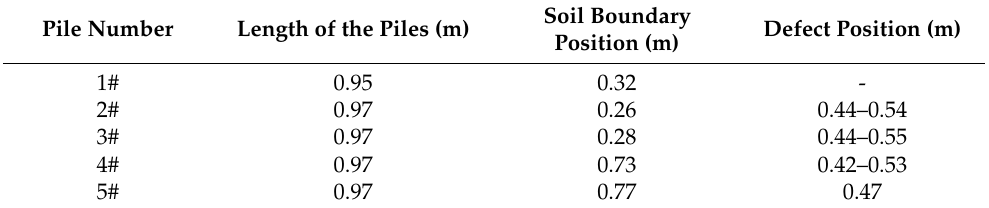
Table 5. Comparison table between finite element simulation results and experimental results.